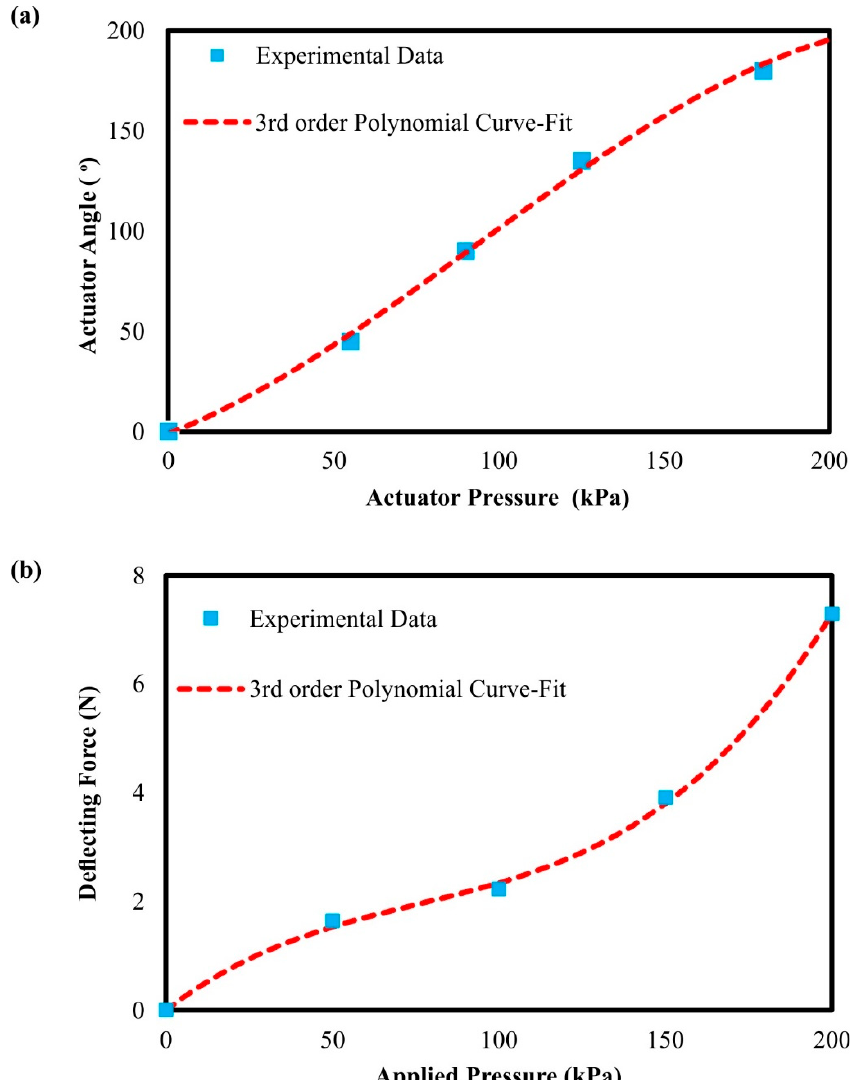
Figure 7. Graphical relationship between: ( a ) the applied pressure and the bending angle of the actuator; and ( b ) the deflecting force produced by the actuator depending on the applied pressure.